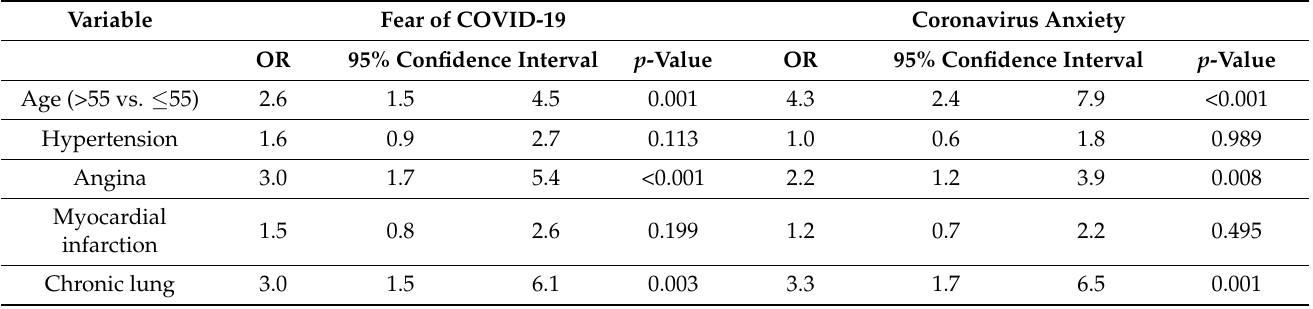
Table 3. Multivariate analysis of factors associated with fear of COVID-19 and coronavirus